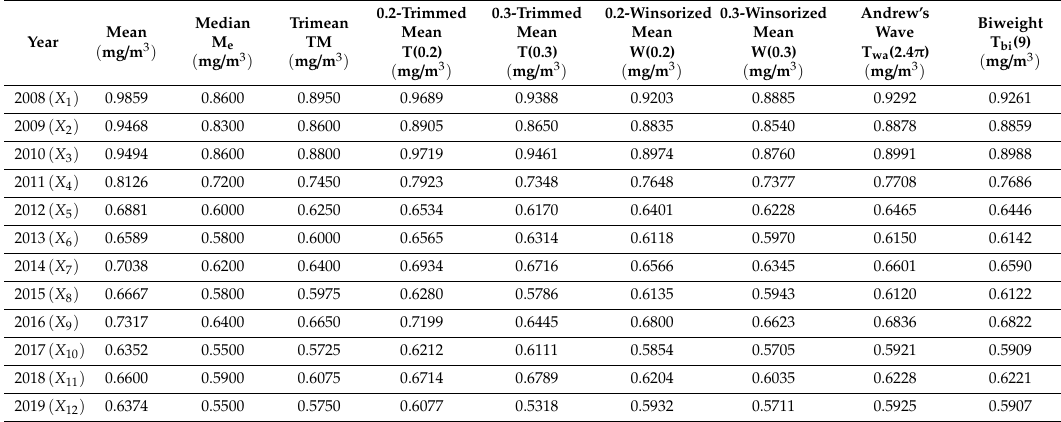
Table 3. Point estimates of